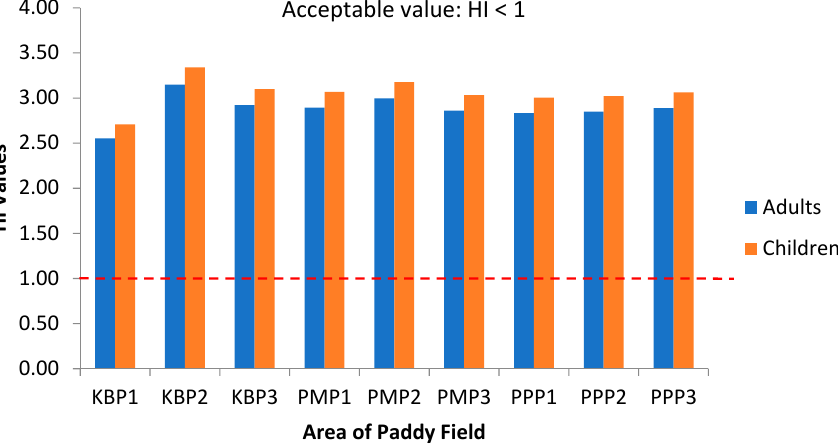
Figure 9. Hazard Index (HI) values of adults and children via intake of rice from the three plots of sampling sites. KBP1: Kota Bharu Plot 1, KBP2: Kota Bharu Plot 2, KBP3: Kota Bharu Plot 3, PMP1: Pasir Mas Plot 1, PMP2: Pasir Mas Plot 2, PMP3: Pasir Mas Plot 3, PPP1: Pasir Puteh Plot 1, PPP2: Pasir Puteh Plot 2, and PPP3: Pasir Puteh Plot 3.